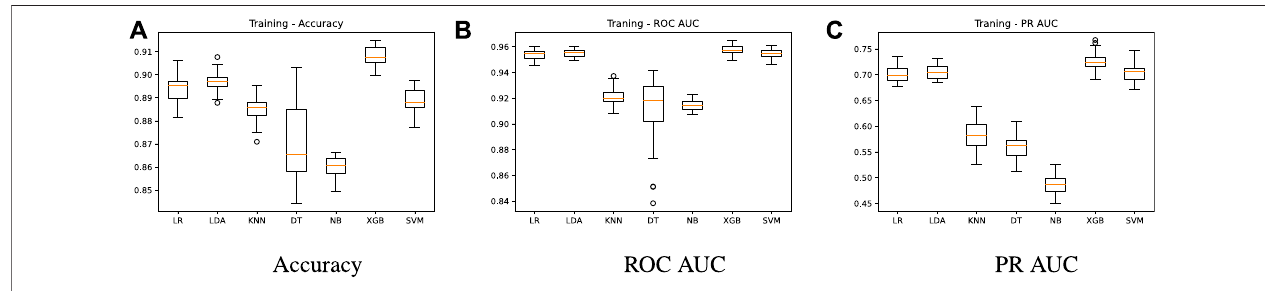
FIGURE 3 | Training results - algorithms comparison.